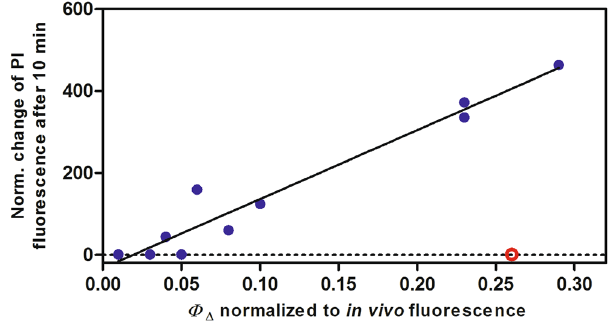
Figure 4. Protein phototoxicity in E . coli cells in relation to singlet oxygen production. Correlation between the extent of cell death, measured by propidium iodide (PI) fluorescence, and the amount of singlet oxygen produced during the first 10-min irradiation period. This was calculated based on multiplying the singlet oxygen quantum yield by the percentage of protein fluorescence remaining after 10-min irradiation. The underlying reason for this correction is that the proteins photobleach to different extent over time (see Supplemental Fig. S4, Fig. 3 and ref. 65 ), hence the rate of singlet oxygen production during the irradiation period considered has decreased concomitantly. The protein fluorescence is a measure of the amount of protein still intact after the irradiation period. The data point indicated by the red circle represents the determined values of the outlier